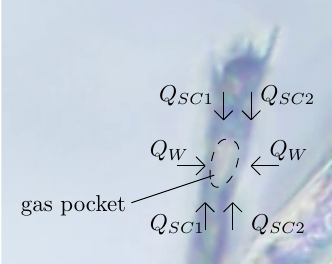
Figure 4. Microscope image of a gas pocket inside a cellulose fiber immersed in beer. The arrows describe the different fluxes of gases (1 for CO 2 and 2 for N stand for diffusion flux across the spherical cap and the fiber’s wall,